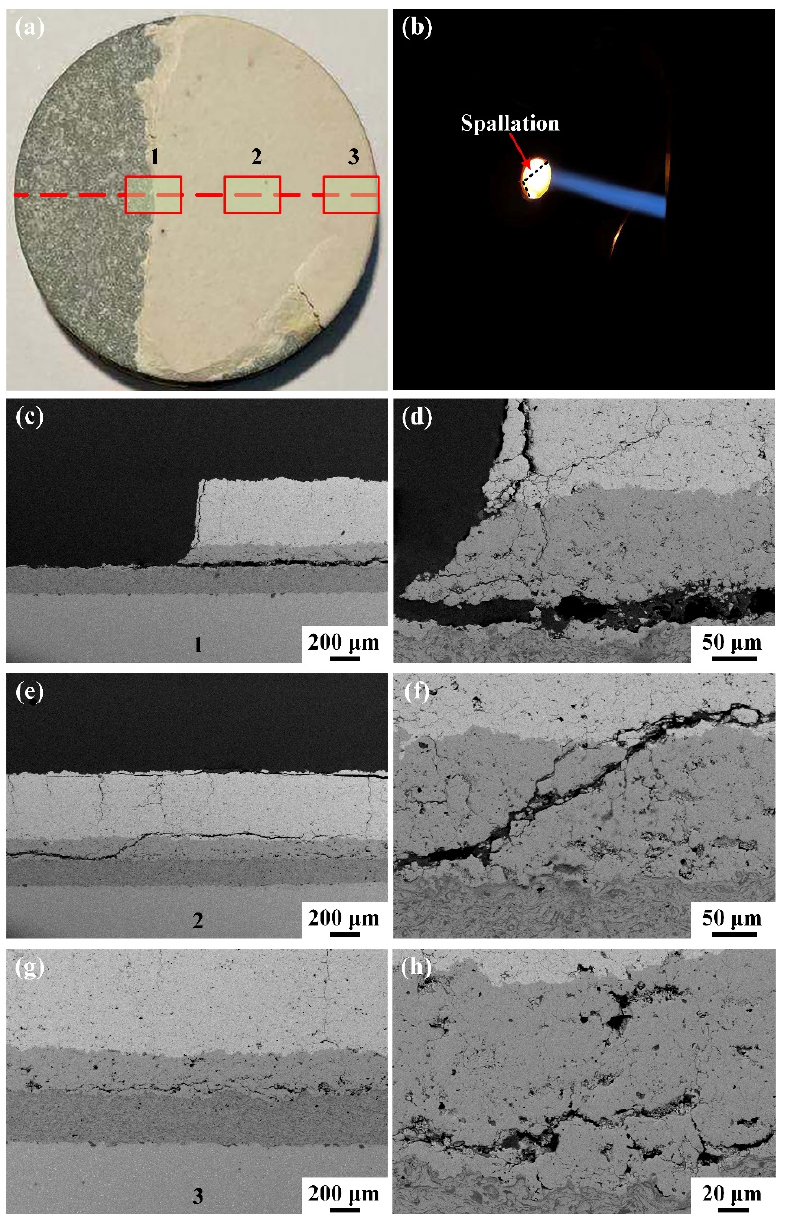
Figure 6. Macroscopic morphologies of the GZ coating ( a ) after thermal shock and ( b ) during thermal shock, and cross-sectional morphologies of ( c , d ) area 1, ( e , f ) area 2, and ( g , h ) area 3.